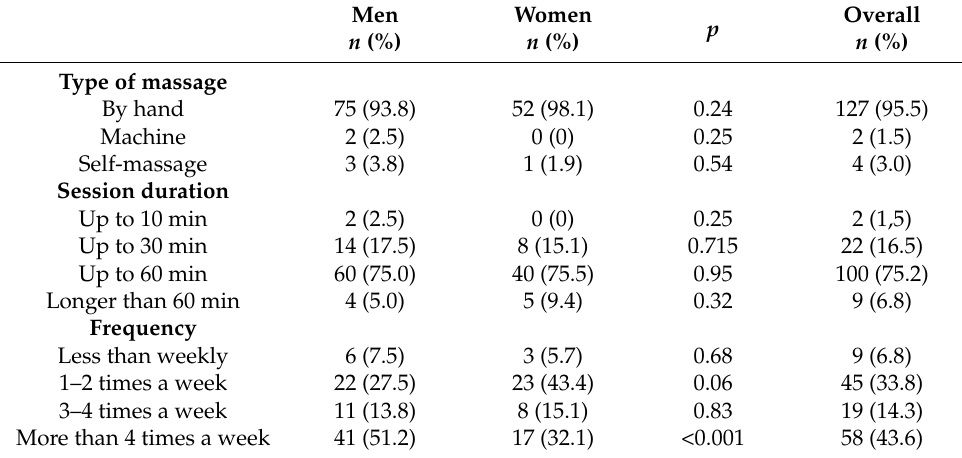
Figure 3. The use of recovery technique according to athletes’ level. Table 7. Massage: type, length, and